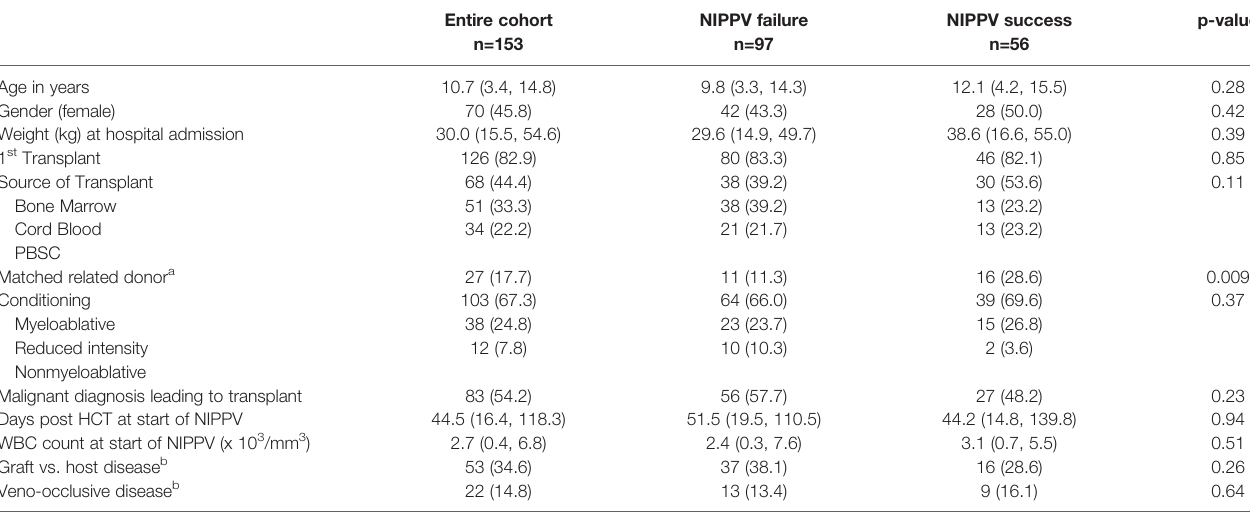
TABLE 1 | Patient characteristics strati fi ed by failure or successful use of noninvasive positive pressure